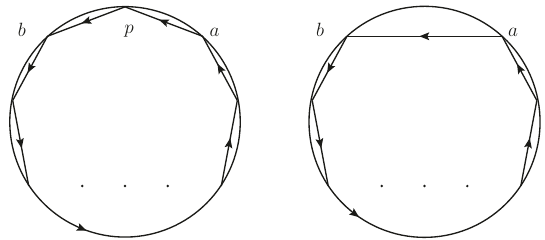
Figure 4 . Two convex polygons correspond to A S ( ··· ,a,p,b, ···|··· ,a,p,b, ··· ) and A S ( ··· ,a,b , ···|··· ,a,b, ··· ) .